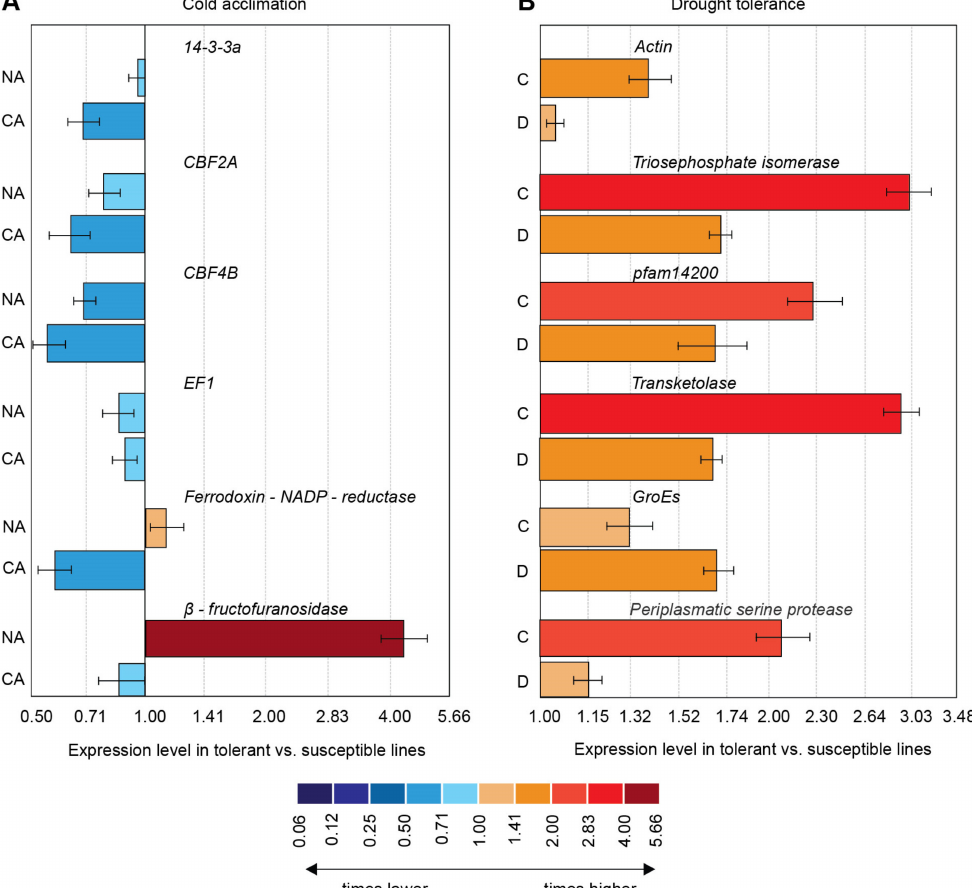
Figure 2. ( A ) Relative expression of genes before (NA) and after cold acclimation (CA) in freezing- tolerant (mean for DH602 and DH534) vs. freezing-susceptible (mean for DH158 and DH575) lines. ( B ) Relative expression of genes in well-watered plants ( C ) and under drought ( D ) in drought-tolerant (mean for DH561 and DH534) vs. susceptible (mean for DH435 and DH602) lines. Error bars represent standard error between the means of two lines (each with three biological replicates and three instrumental